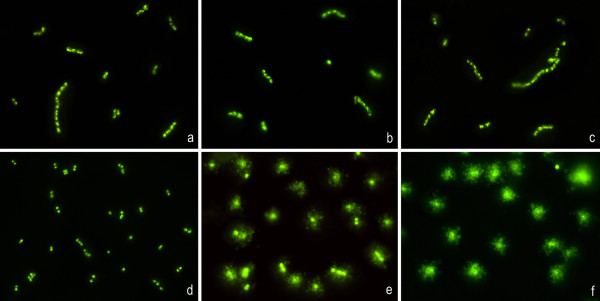
Two strains of Enterococcus spp., one resistant (above: a, b, c) and one susceptible (below: d, e, f), exposed to vancomycin, 0 μg/ml (left: a, d), 4 μg/ml (medium: b, e) and 32 μg/ml (right: c, f) and processed by the procedure to assess cell wall integrity. Whereas the resistant strain does not show lysis after vancomycin doses, the sensitive strain is clearly affected. There is no evidence of background of extracellular DNA fragments.